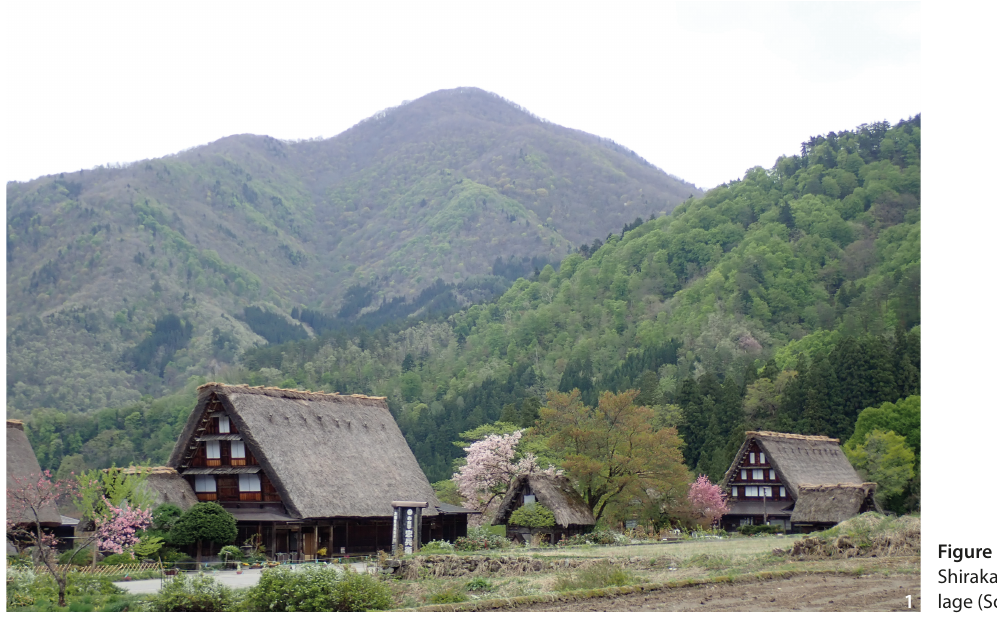
Figure 1 Gassho-style houses in Shirakawa mura Ogimachi